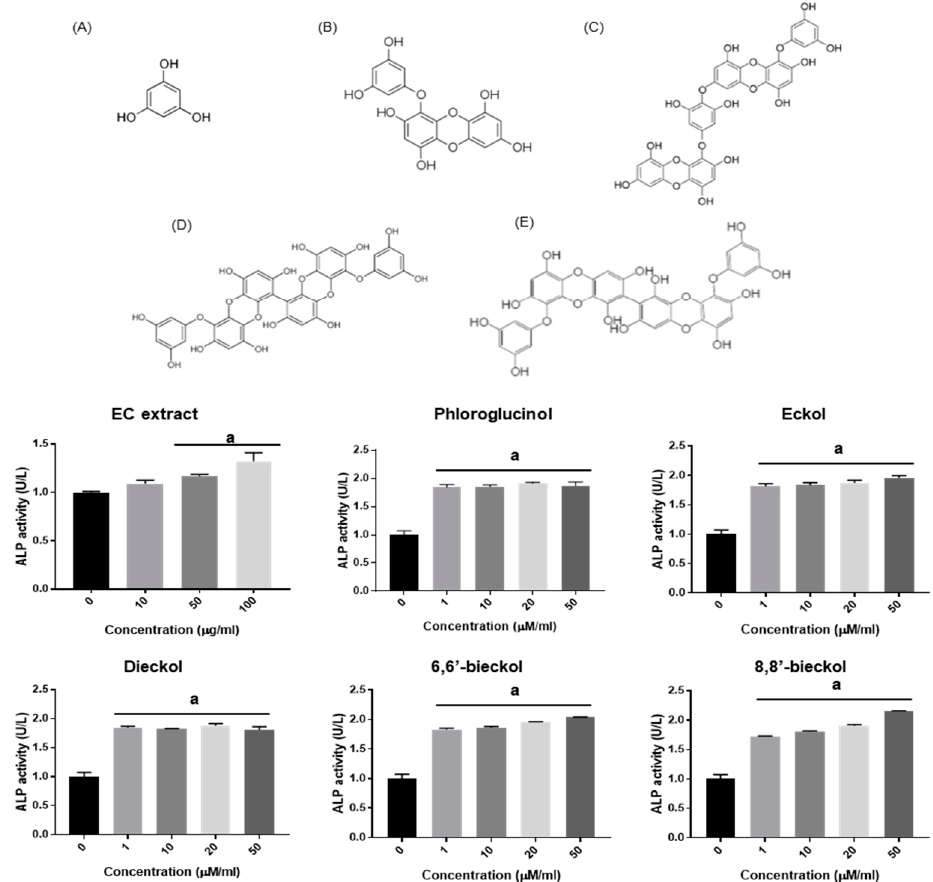
Figure 2. The chemical structures and effects of EC extract and its components (( A ) phloroglucinol, ( B ) eckol, ( C ) dieckol, ( D ) 6,6 ′ -biekcol, and ( E ) 8,8 ′ -bieckol) on the ALP activity in MC3T3-E1 cells. EC extract, phloroflucinol, eckol, dieckol, 6,6 ′ -biekcol, and 8,8 ′ -bieckol were measured using a mi- croplate reader at a wavelength of 405 nm. a p < 0.05 vs. the control group.